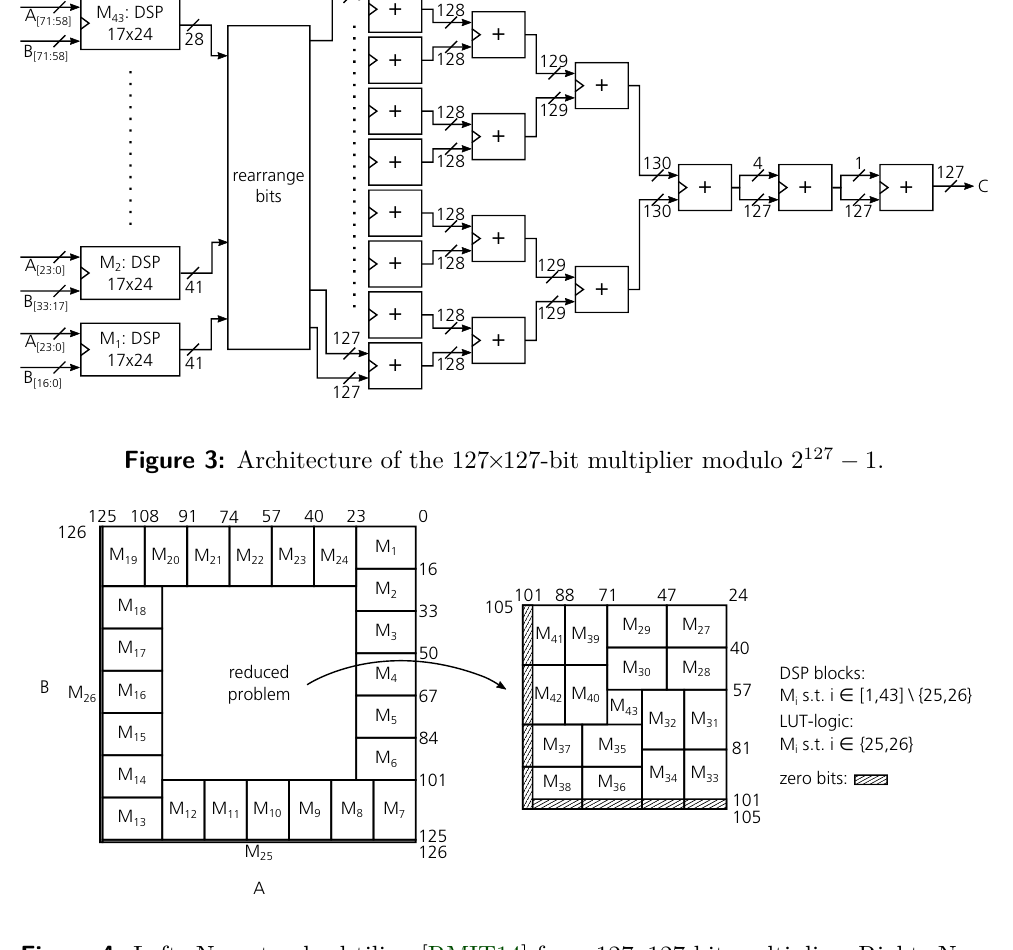
Figure 4: Left: Non-standard tiling [RMIT14] for a 127 × 127-bit multiplier. Right: Non- standard tiling for smaller a 78 × 78-bit